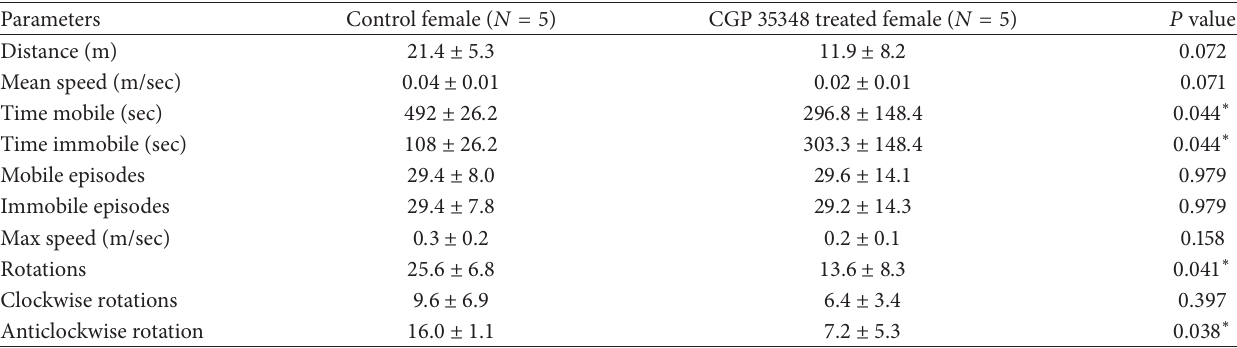
Table 1: Comparison of the studied open field parameters between saline and CGP 35348 treated female albino mice. 𝑃 values indicate the results of two-sample 𝑡 -test.